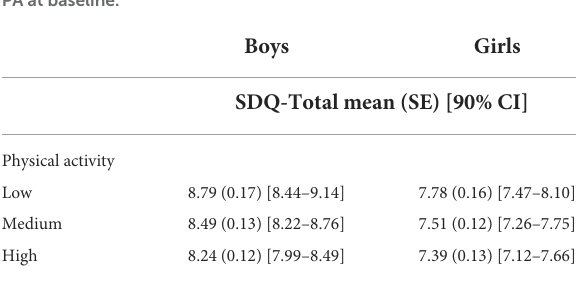
correlation between PA and SDQ-H/I was only significant at Baseline ( r s = −